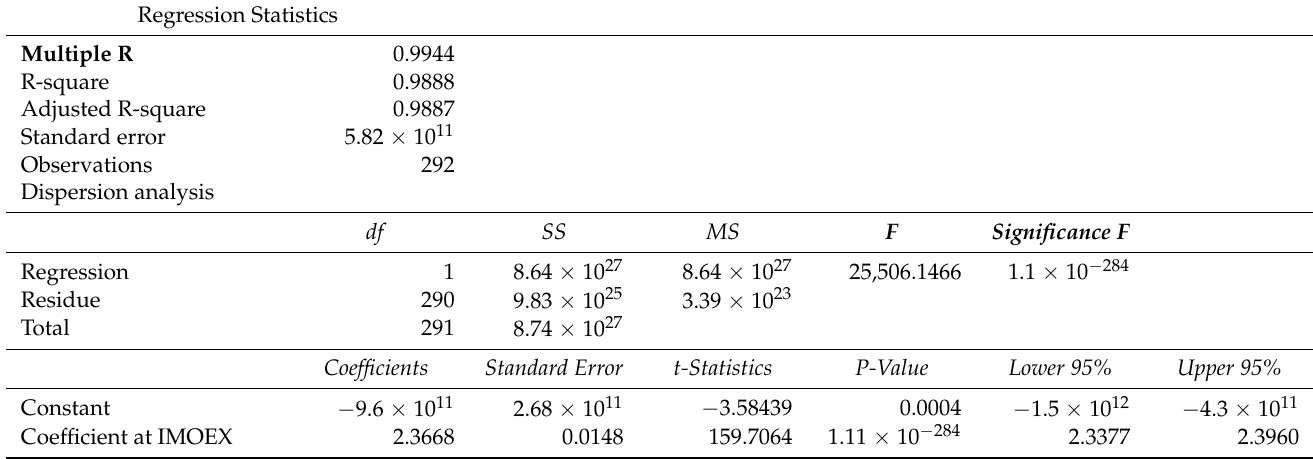
Table 6. Dataset modelling of the impact of the Index of the Moscow Exchange (IMOEX) on the Sustainable Development Vector Index (MRSV) in Russia from 21 September 2020 to 11 November